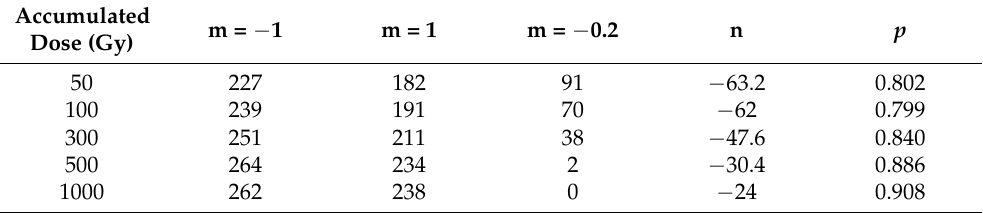
Table 4. Matching results of